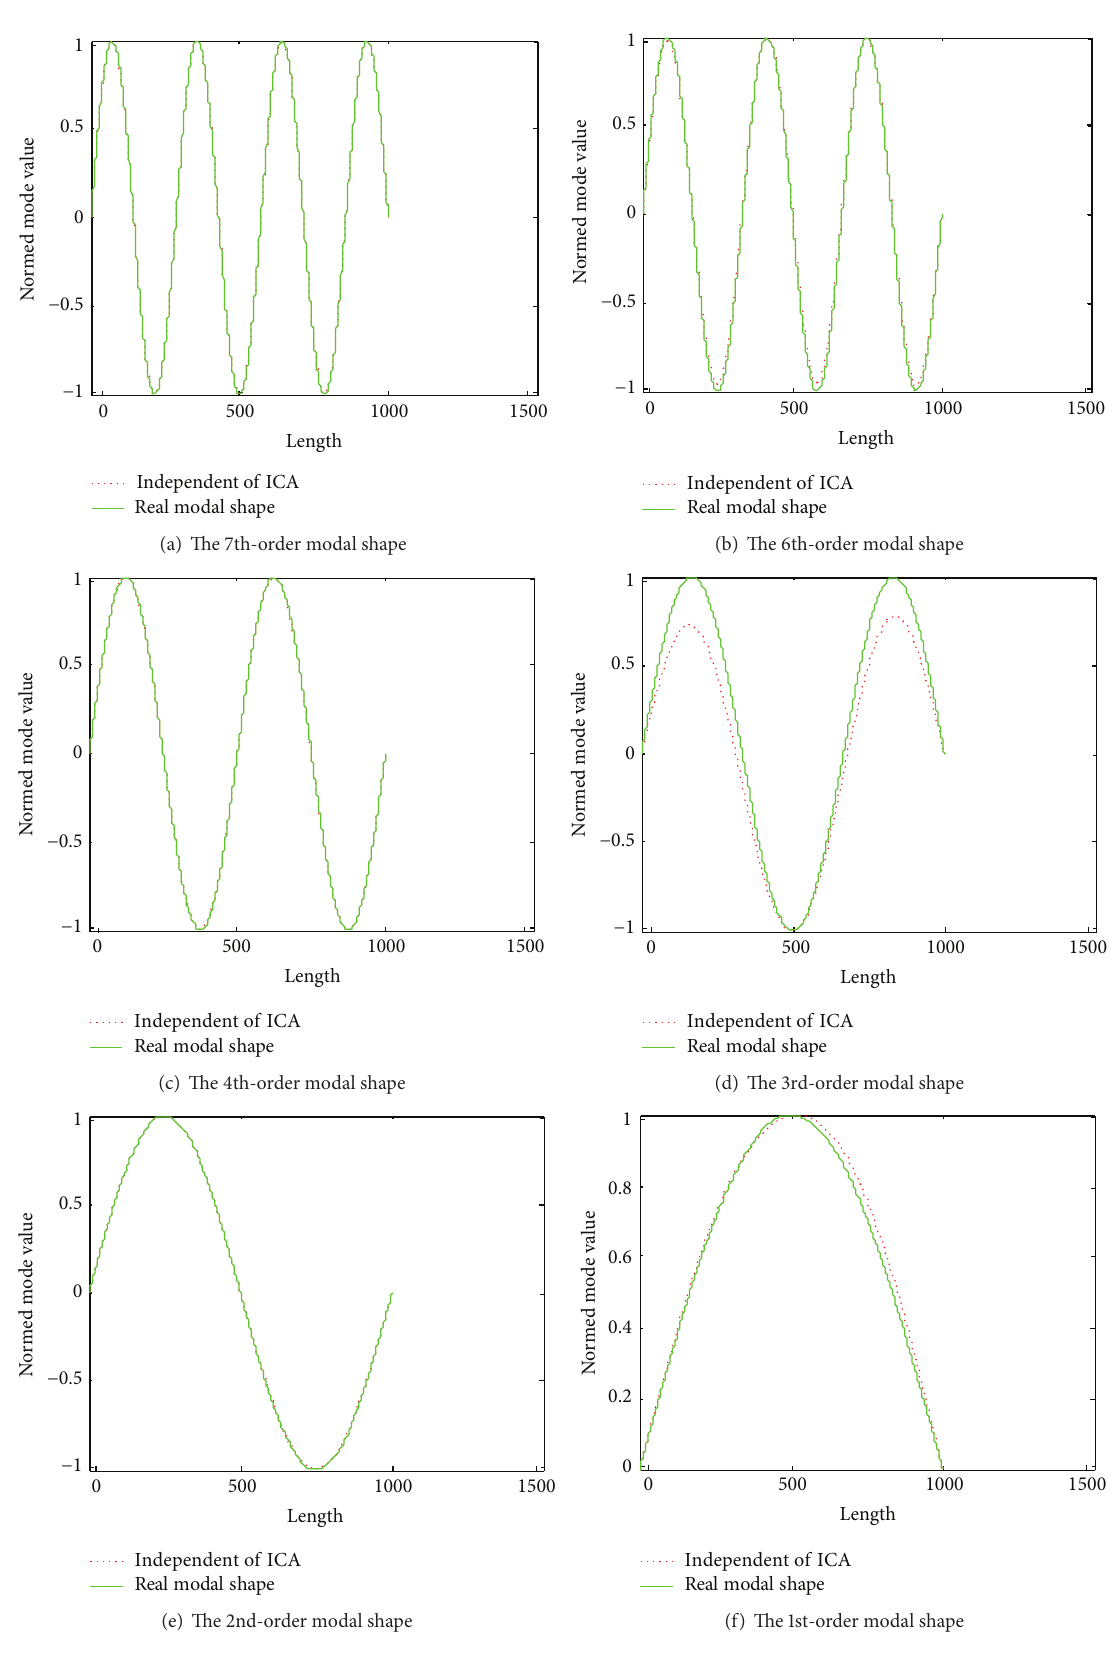
Figure 8: Modal shape comparison between FEA and separating vector by minimum mutual information with gradient descent